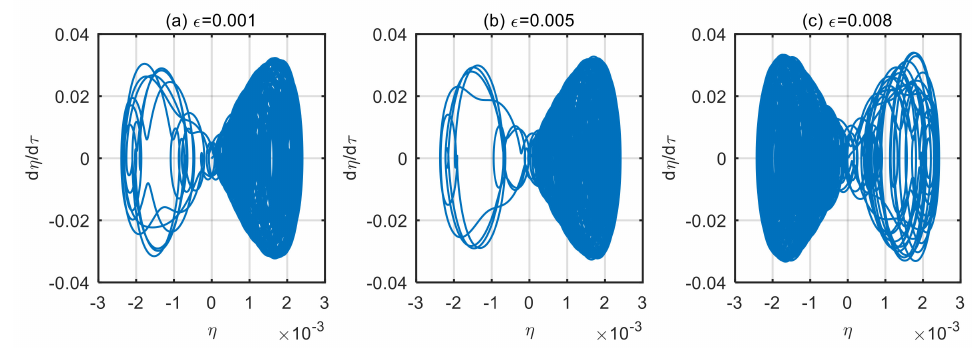
Figure 7. Motion phase diagram of microtubes with different dimensionless amplitude of the excitation loads ( u = 10). ( a ) ε = 0.001; ( b ) ε = 0.005; ( c ) ε =